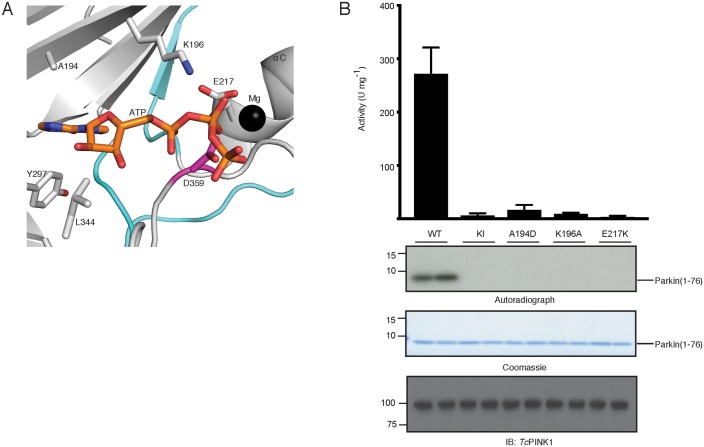
Mutations in the TcPINK1 ATP binding pocket result in loss of kinase activity.(A) ATP (orange sticks) was modeled in the TcPINK1 structure using superposed coordinates of cAMP-dependent protein kinase in complex with ATP (pdb id:1ATP), TcPINK1 residues involving interactions with ATP are shown in grey sticks, remaining features of TcPINK1 are colored as in Figure 1B. (B) Parkin Ubl phosphorylation assay with full-length TcPINK1 (WT), kinase-inactive D359A mutant (KI), and ATP-binding pocket mutants A194D, K196A and E217K. 30 ng of indicated enzyme was incubated in the presence of 2 μM Ubl domain of Parkin (1-76) and [y-32P] ATP for 10 min. Reactions were terminated by addition of SDS sample buffer and separated by SDS-PAGE. [γ-32P] incorporation visualised by autoradiography (upper panel), followed by Cerenkov counting of substrate bands for quantification (top panel), western blot against TcPINK1 (lower panel) and Coomassie stained gels showing UBL (middle panel) are used as loading control.